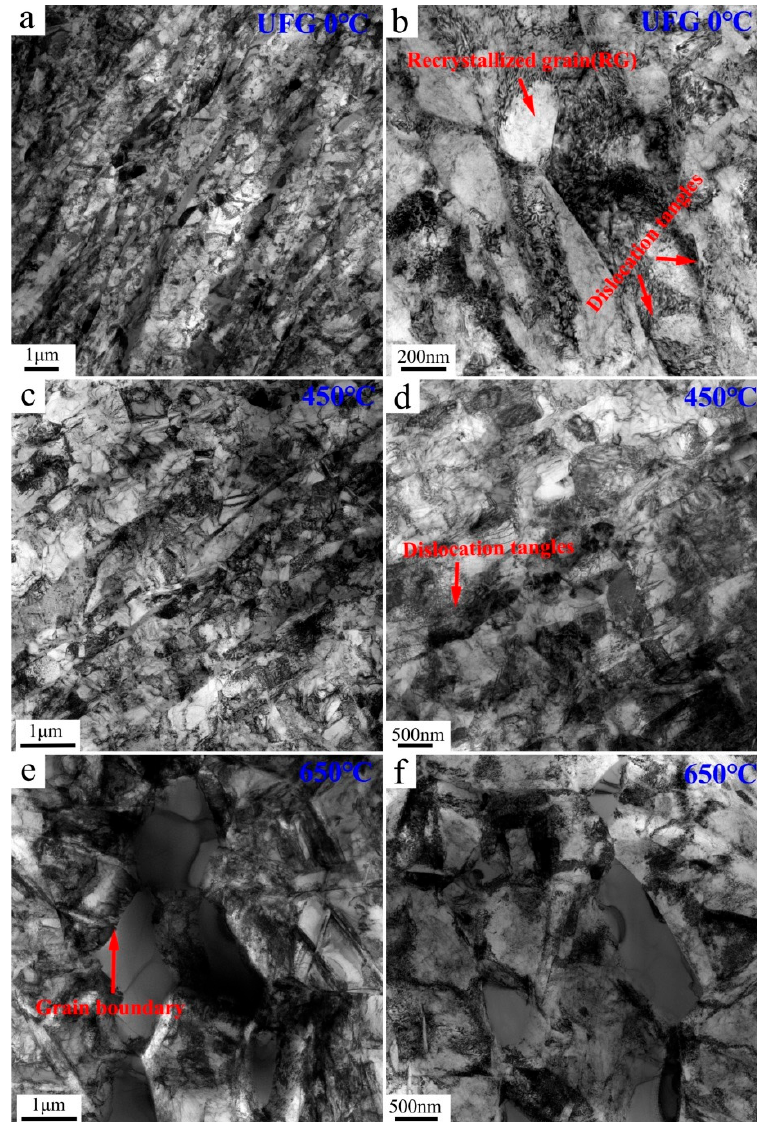
Figure 8. TEM micrographs of ( a , b ) the UFG TiFeB alloy samples, and the samples annealed at ( c , d ) 450 °C and ( e , f ) 650 °C